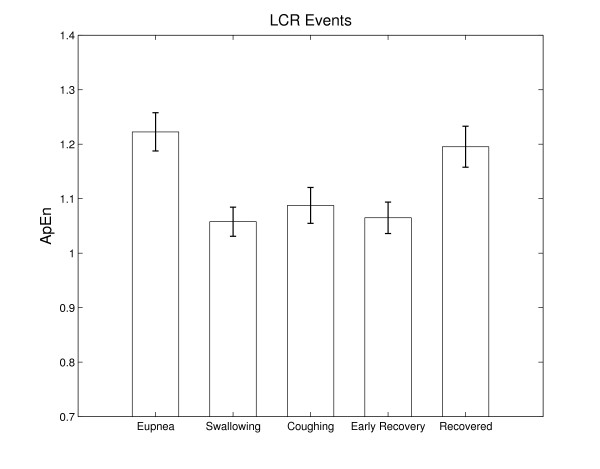
Approximate entropy values during LCR: Approximate entropy values ± standard error for the 5 characteristic groups of respiratory patterns during the LCR: regular (eupneic) breaths, swallowing, coughing, early recovery breaths following apnea and fully recovered breaths. Results represent averages of entropy values of 3 measurements for each of the 5 animals under study.